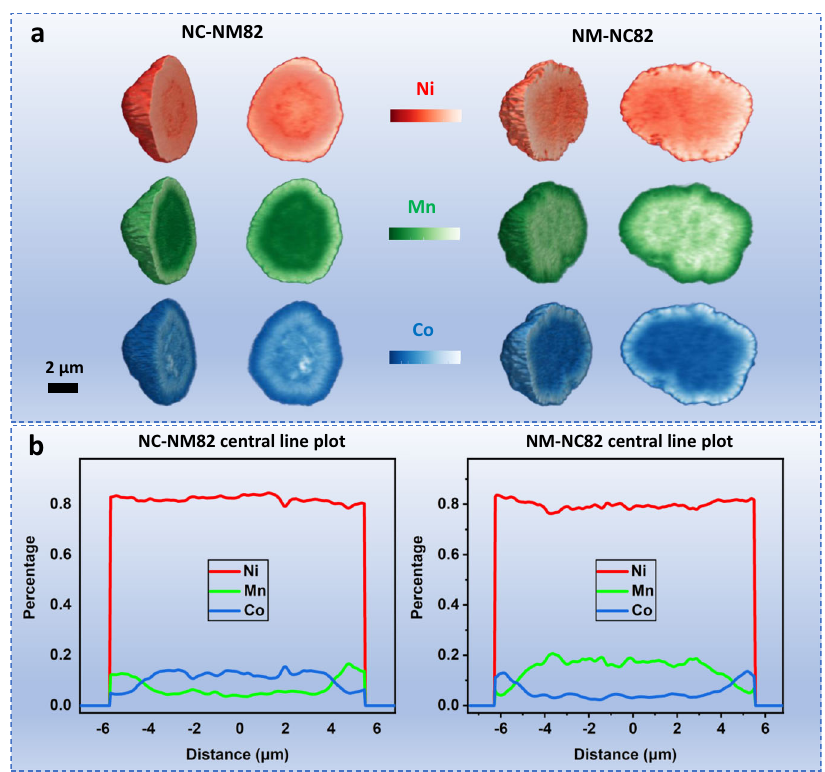
Fig. 3 Spatial element distribution of two gradient cathodes. a 3D tomography reconstruction from individual particles and spatial element distributions of Ni (red), Mn (green)n and Co (blue), detected by fl uorescence-yield scanning probe X-ray microscopy. The element content is re fl ected by the brightness of the color sets, where the brighter the color, the higher the element content. b Central line scanning plots of NC-NM82 and NM-NC82 for the compositional